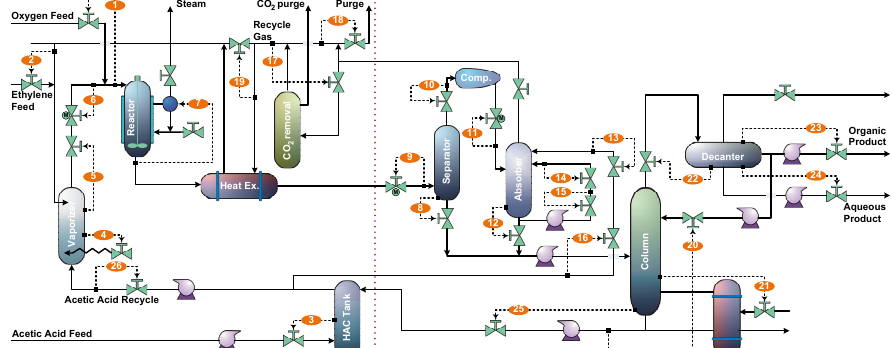
Figure 4. The physical architecture of the Vinyl Acetate Monomer process (VAMP) and the associated control loops (illustrated by